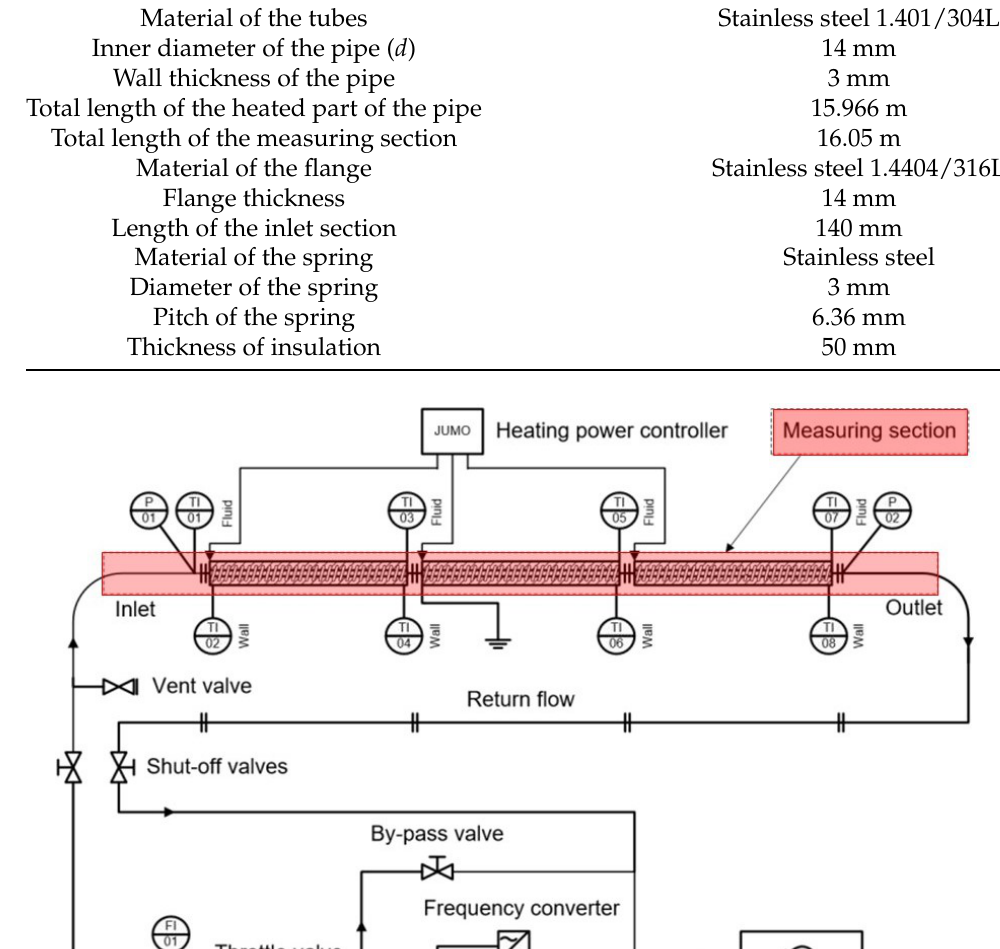
Table 1. Geometrical details of the components in the experimental test rig.